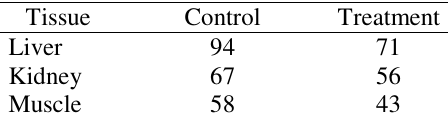
Table 2 . Cl - ion concentration in meq. kg –